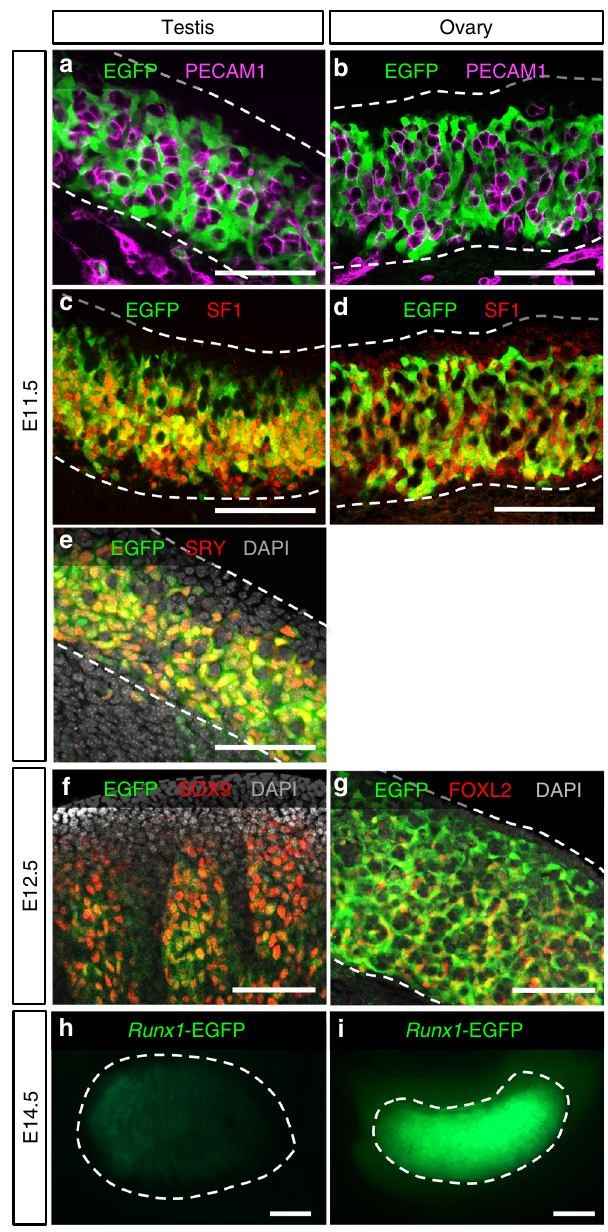
Fig. 2 Runx1 is expressed in the supporting cells during gonad differentiation. a – g Whole-mount immuno fl uorescence of XY and XX gonads from Tg(Runx1-EGFP) reporter mice at E11.5 and E12.5. Gonads with endogenous EGFP were co-labeled with markers for germ cells/vasculature (PECAM-1; a , b ), somatic cells (SF1; c , d ), Sertoli cells in XY gonads (SRY in e and SOX9 in f ), and for pre-granulosa cells in XX gonads (FOXL2; g ). Scale bars: 100 µ m. Single-channel images are provided for e , f in Supplementary Fig. 1. h , i Detection of endogenous EGFP in freshly collected E14.5 gonads. Scale bars: 200 µ m. Dotted lines outline the gonads. At least three independent biological replicates were analyzed and the images presented are representative of all